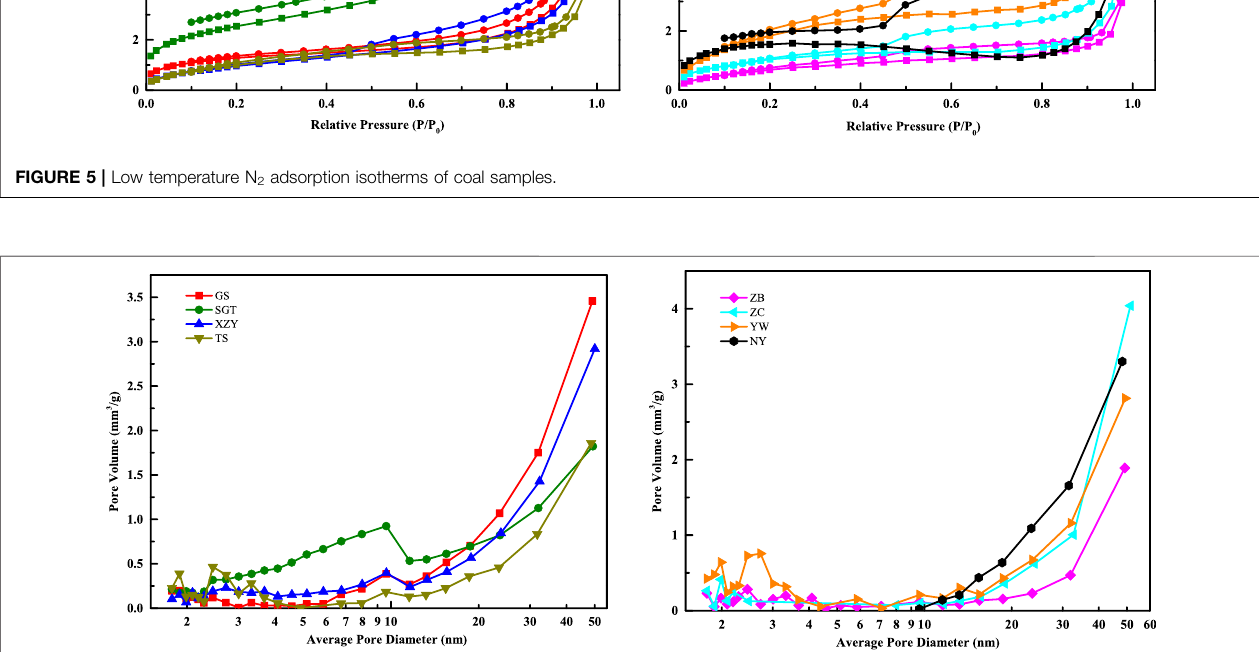
FIGURE 6 | Pore size distribution of coal samples obtained by BJH theory.